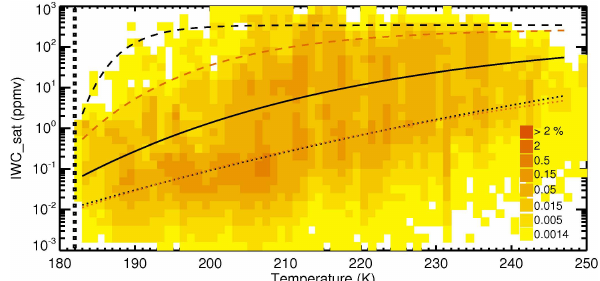
Fig. 5. IWC as a function of temperature. Color scheme is the fre- quency of data points with respect to the total number of sampled data. The overall data base represents 38.4h (138240 data points) of in-cloud sampling as noted in Table 1. Black solid/dashed dotted lines are median/maximum/minimum IWC, red dashed/dotted lines encompasses the core IWC region of the climatology of Schiller et al. (2008).